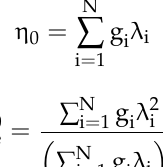
Table 5. Rheological parameters by Cross model fitting of viscosity curves .